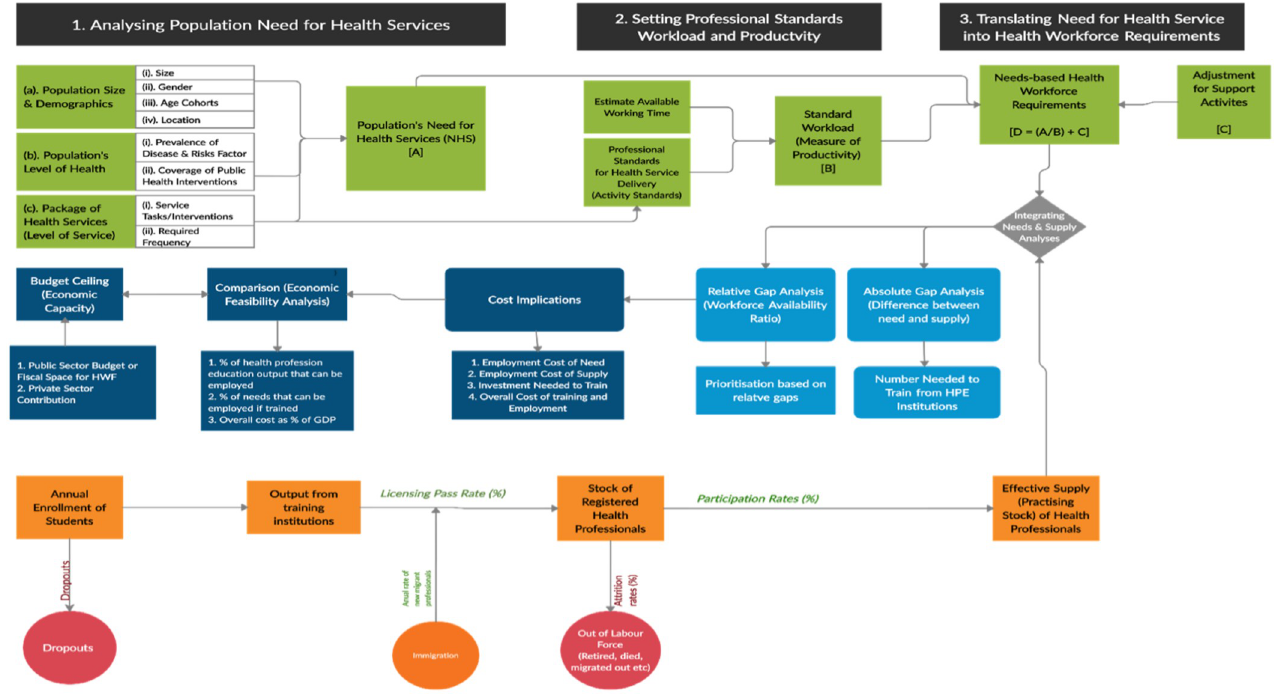
Fig 2. A conceptual framework for the population needs-based simulation model for health workforce planning. Source: Adopted from Asamani et al. [27].